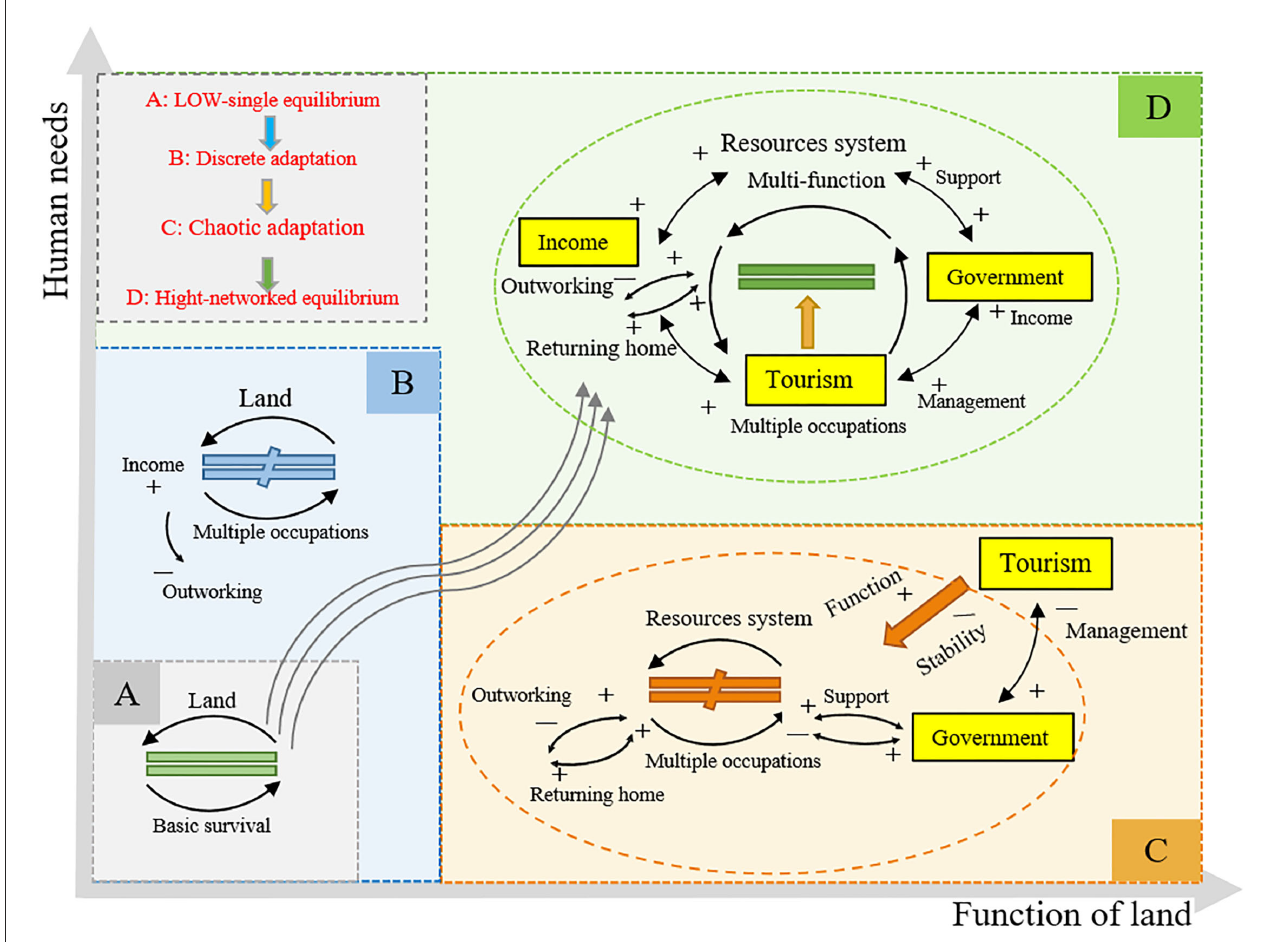
FIGURE10 Evolutionary cycle of livelihood vulnerability dynamics: (A–D) are the four livelihood vulnerability cycles, respectively. The progression of the cycle is accompanied by the fluctuation in land functions on the horizontal axis and human needs on the vertical axis. The disturbance systems represented by tourism and government emerge in stages (C, D) . Their feedback relationships with land functions and human needs